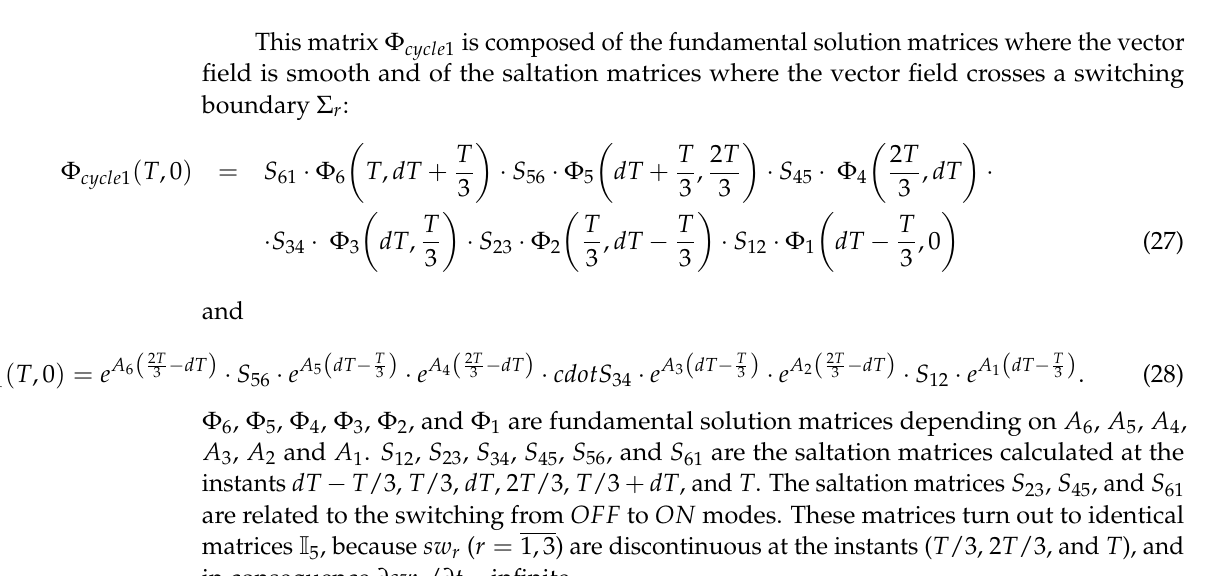
Figure 5. Diagram of the transition matrices and the saltation matrices in healthy switching case h 1 = h 2 = h 3 =